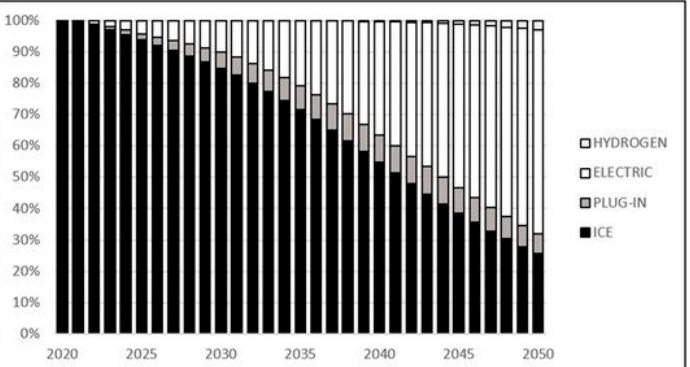
Figure 1. Structure of passenger cars in Poland in the years 2020–2050 by engine type according to Rabiega et al. (2021) [22].